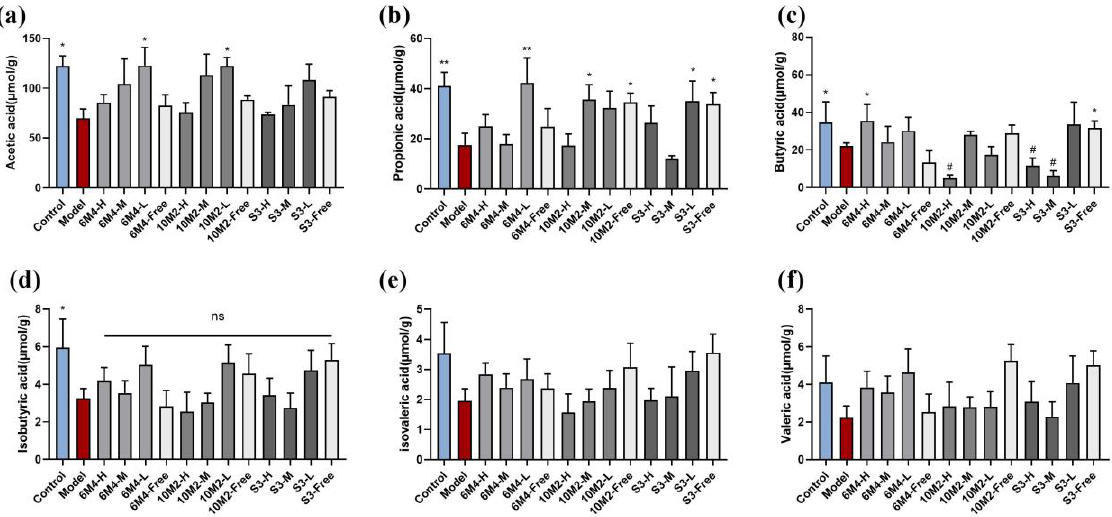
Figure 4. The short-chain fatty acid level of fecal samples by GC-MS. ( a ) Acetic acid ( µ mol/g); ( b ) propionic acid ( µ mol/g); ( c ) butyric acid ( µ mol/g); ( d ) isobutyric acid ( µ mol/g); ( e ) isovaleric acid ( µ mol/g); ( f ) valeric acid ( µ mol/g). Data are shown as mean ± SD ( n = 6). * p < 0.05, ** p < 0.01, com- pared with the model group. # p < 0.05, compared with the control group. ns, not significant.